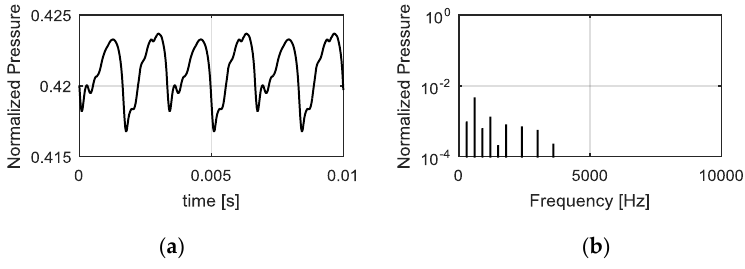
Figure 10. Outlet pressure ripple depending on time ( a ) and frequency ( b ).